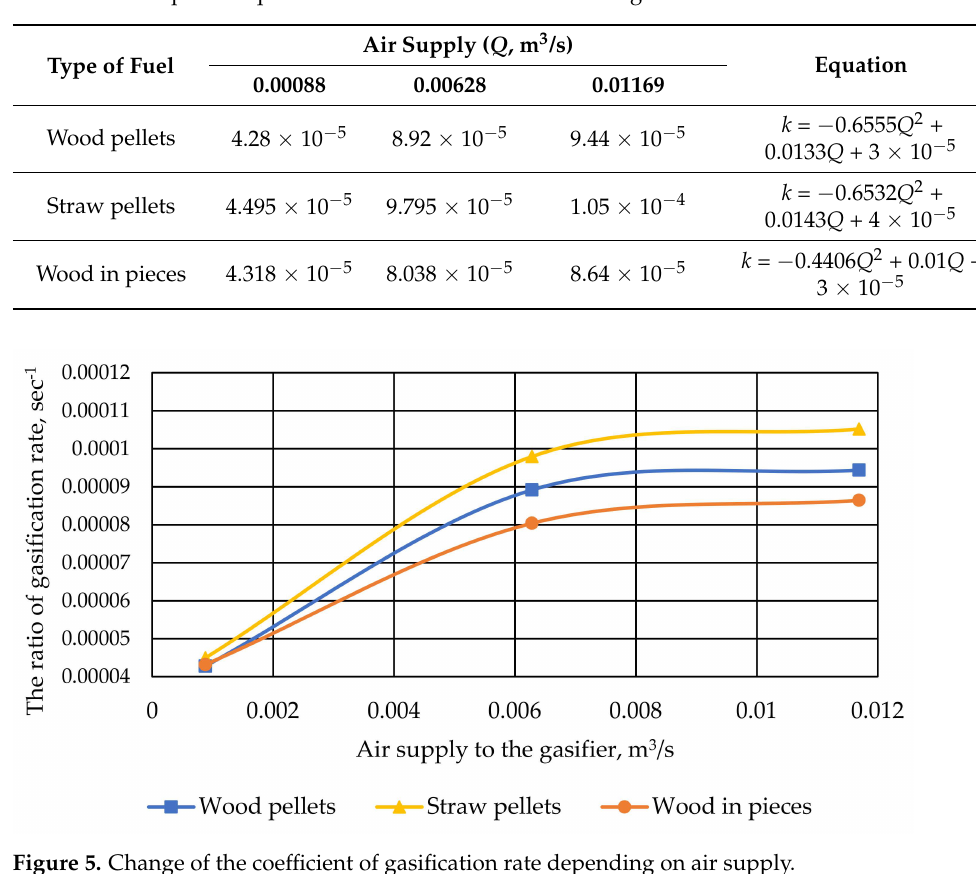
Table 5. The empirical equations of rate coefficient of biomass gasification.